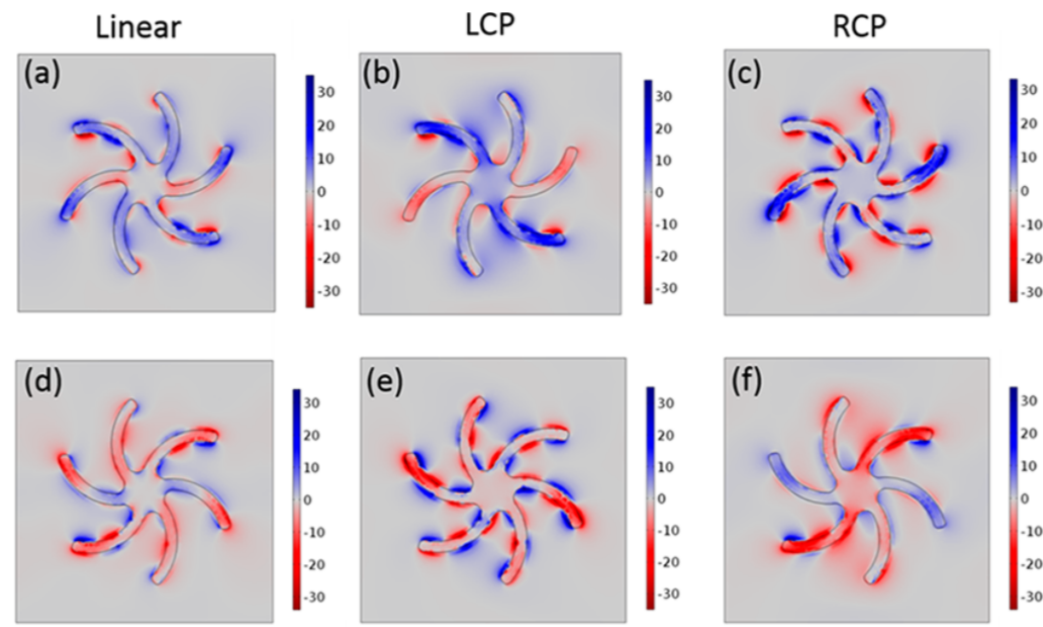
Figure 3. Calculated chiral density near-field maps for a shuriken-shaped structure in water for ( a )–( c ) left-handed (LH) and ( d )–( f ) right-handed (RH) geometries. Results are presented for LCP, RCP, and linearly polarized incident light. Reproduced with permission from ref. [57]. Copyright 2018 American Chemical